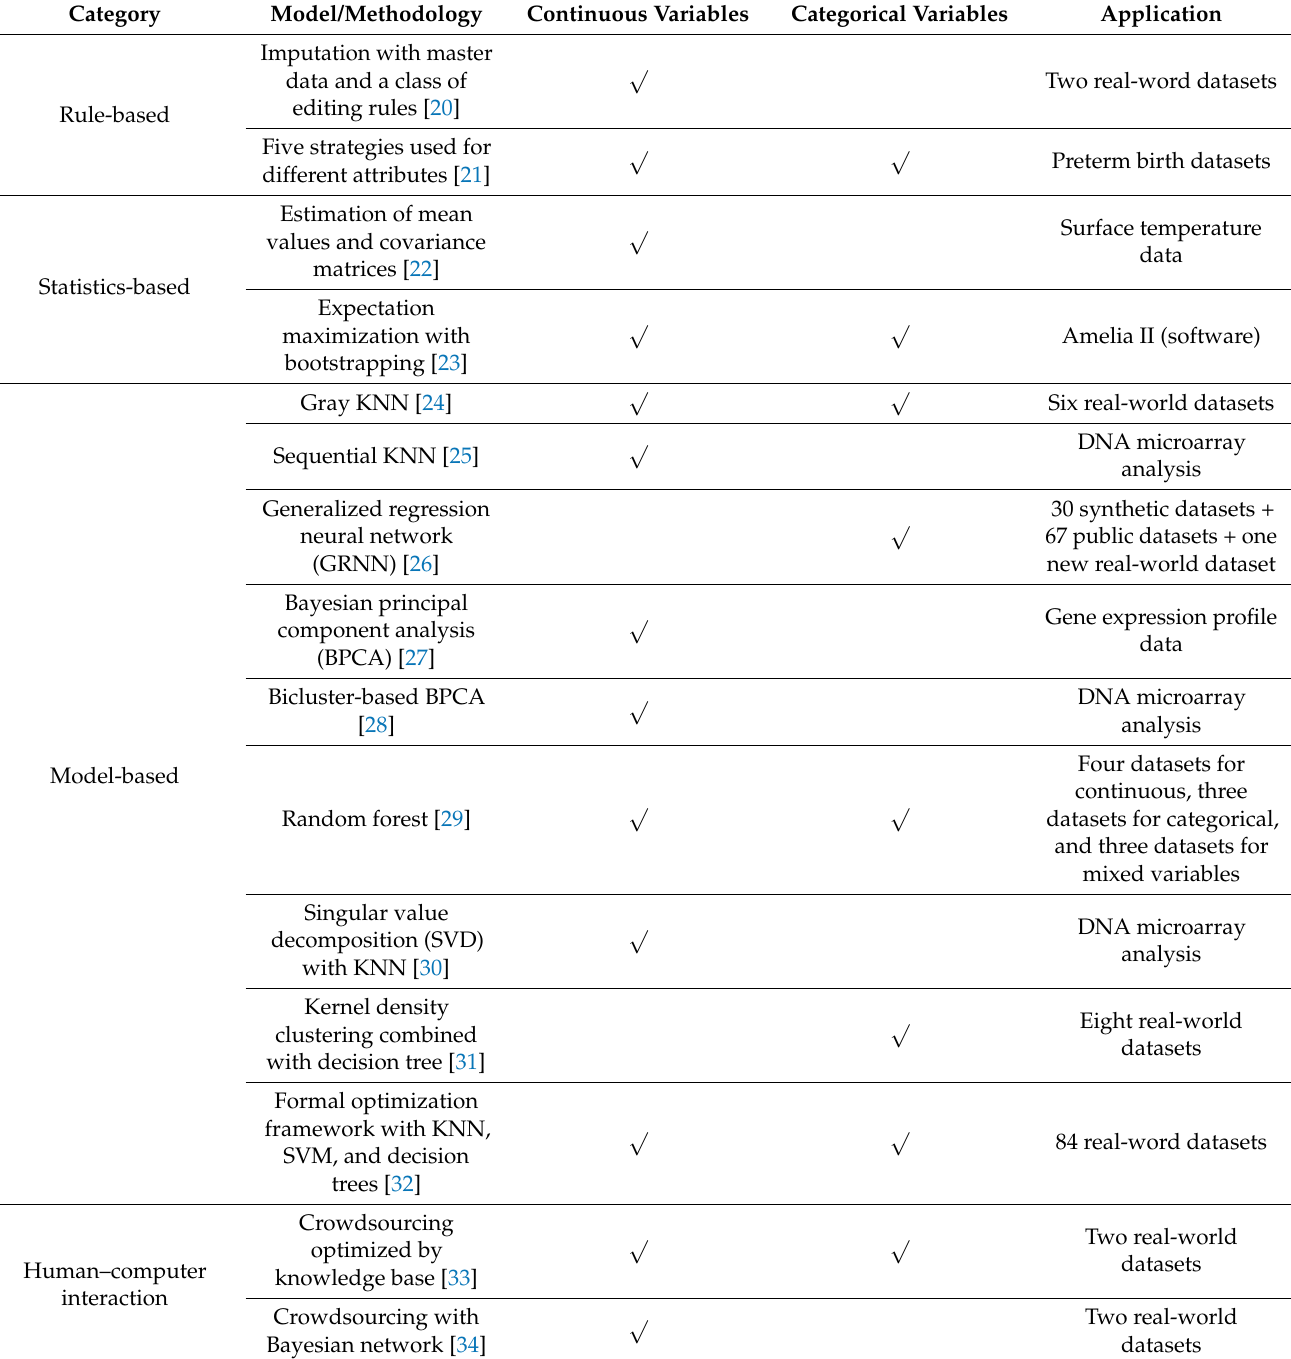
Table 1. Missing values imputation